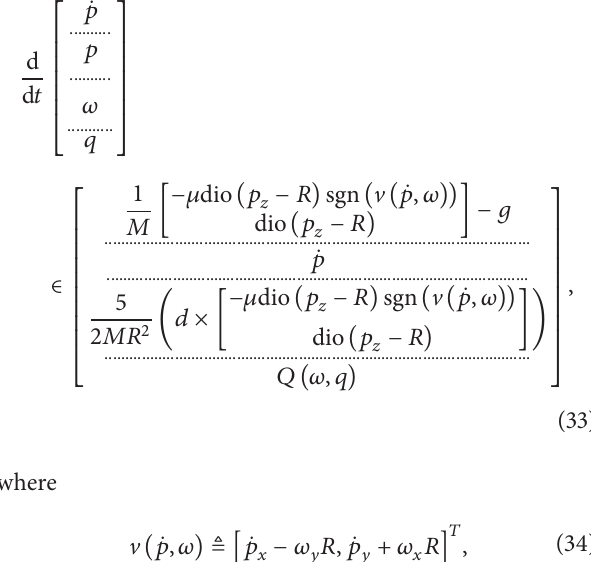
𝜔 ∈ R 3 be the angular velocity of the object. Let 𝑅 and 𝑀 be the radius and the mass of the object, respectively, and let 𝜇 be the friction coefficient between the object and the